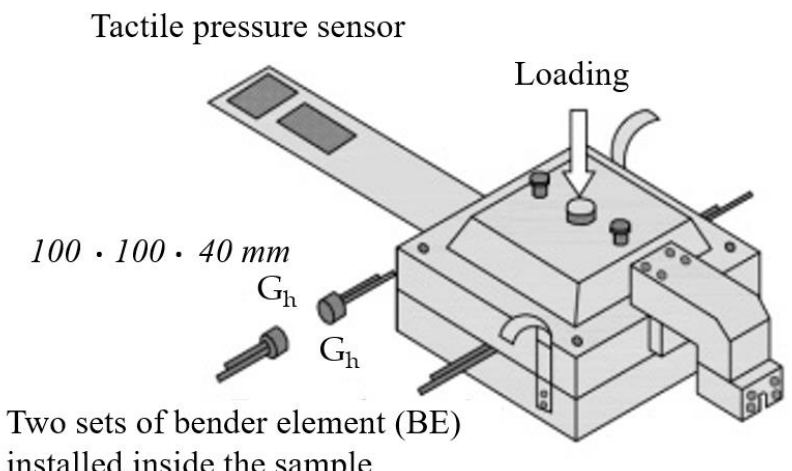
Figure 20. Tailor-made odometer with the tactile pressure sensor and two sets of bender elements installed inside the sample (after [70]; available via 2013 ISSMGE’s permission concerning the conference materials).